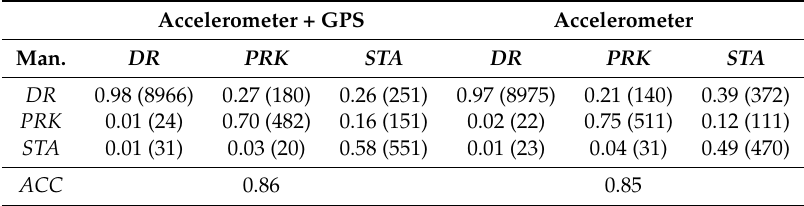
Table 17. System’s confusion matrices with and without GPS